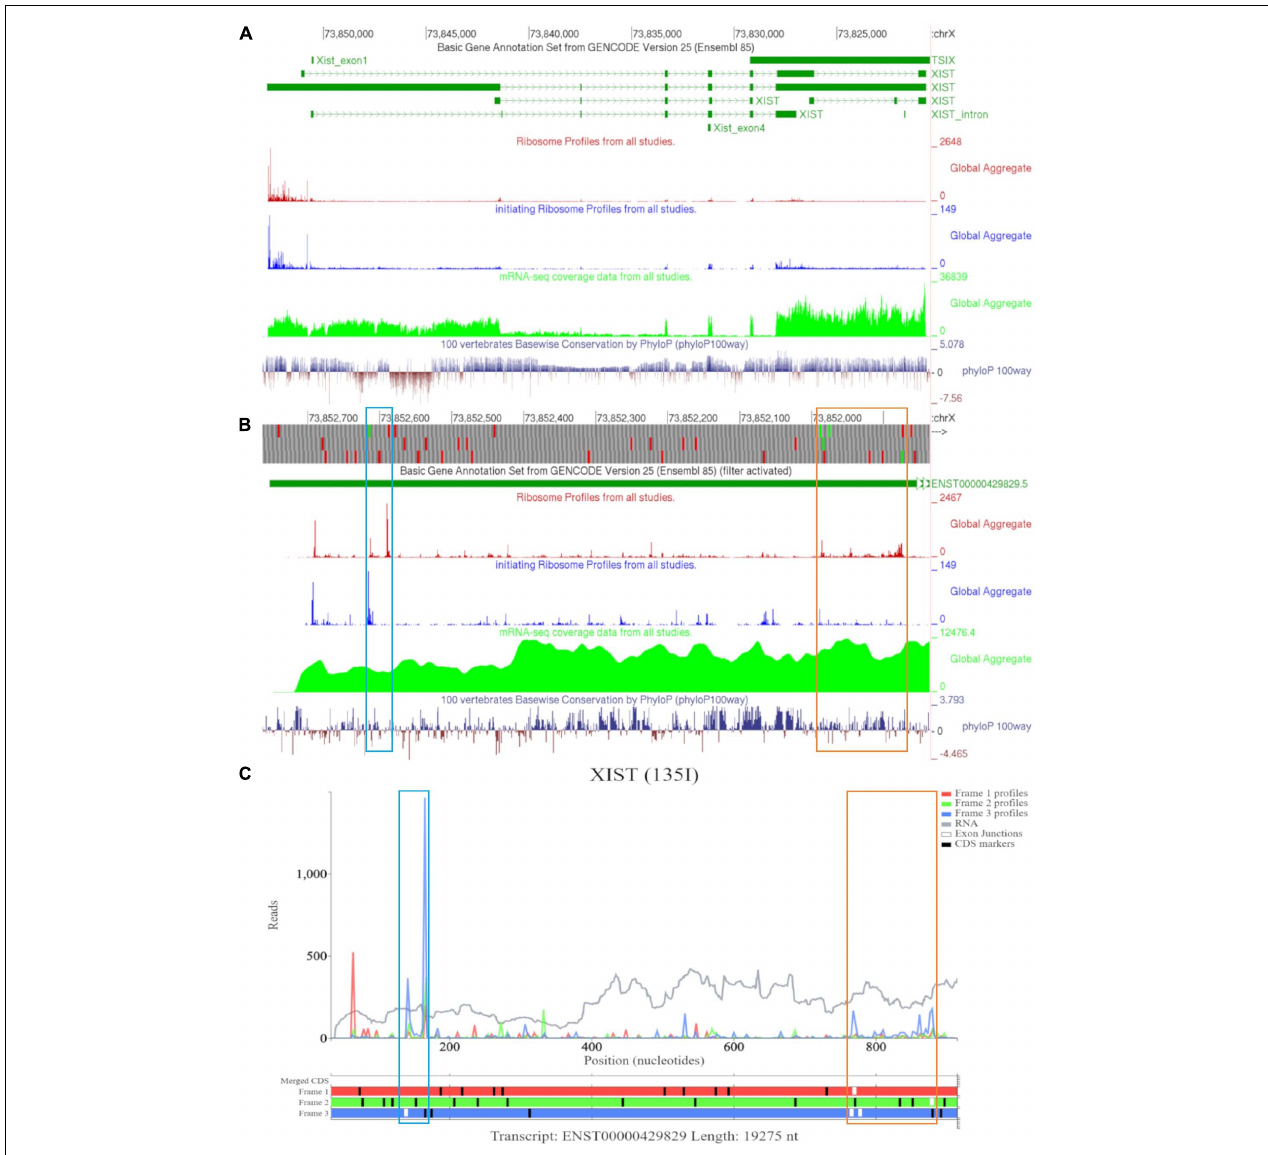
FIGURE 8 | Visualization of XIST in GWIPS-viz and Trips-Viz. (A) Whole transcript view of XIST in GWIPS-viz with the tracks described in Section Setup and Configurations enabled. (B) Visualization of the 5 (cid:48) end of XIST isoform ENST00000429829 in GWIPS-viz with the tracks described in Section Setup and Configurations enabled. Two translated ORFs are outlined in blue and orange, respectively. (C) Visualization of the 5 (cid:48) end of transcript ENST00000429829 in Trips-Viz. The two translated ORFs previously outlined in blue and orange on GWIPS-viz are similarly outlined again.